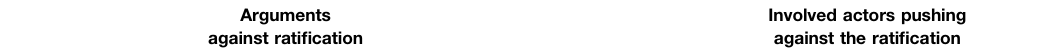
Involved actors pushing against the rati fi cation